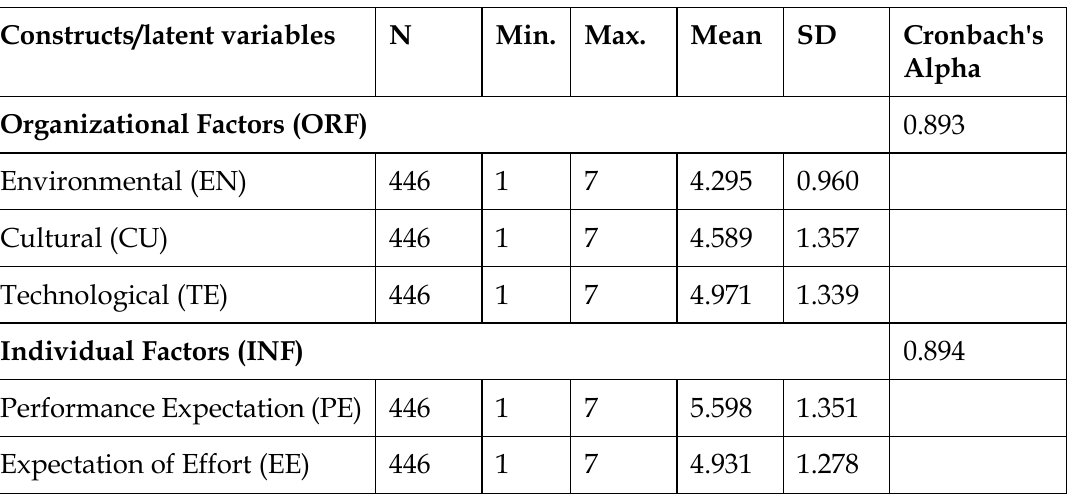
Table 3: Descriptive statistics and internal